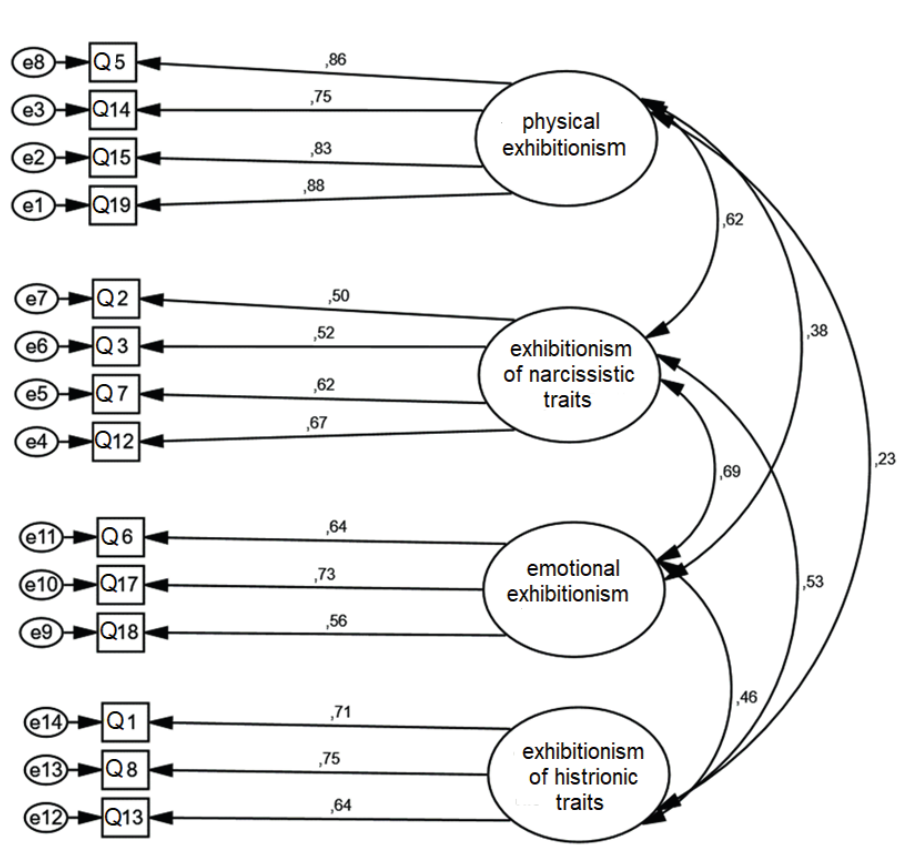
Fig. 1. The confirmatory factor analysis for the Media Exhibitionism Questionnaire - standardised regression coefficients (source: own Table 5. Cutoff points as initial standards setting a threshold point for the occurrence of exhibitionism Scale